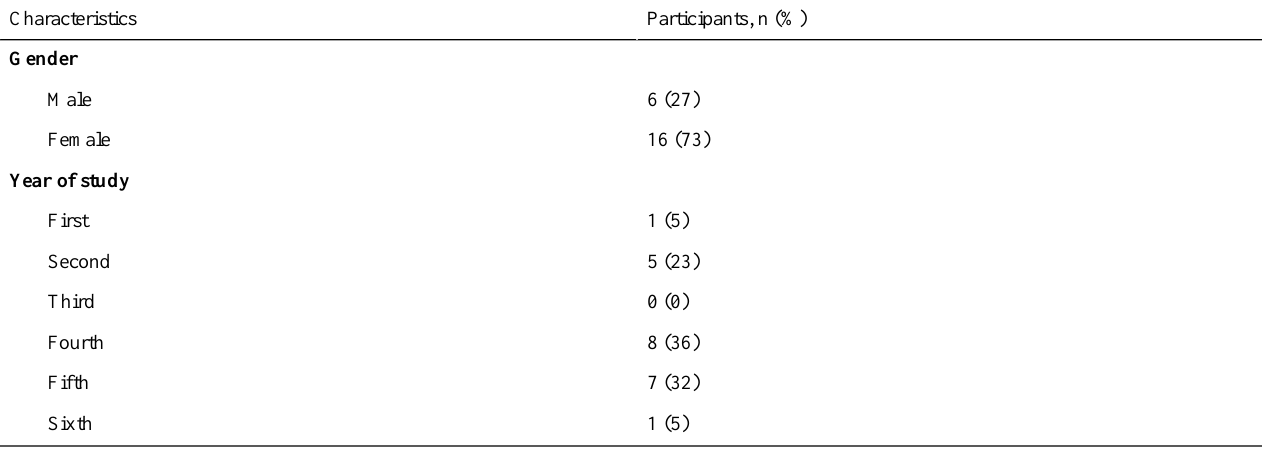
Table 1. Demographic data of participants in the questionnaire phase.